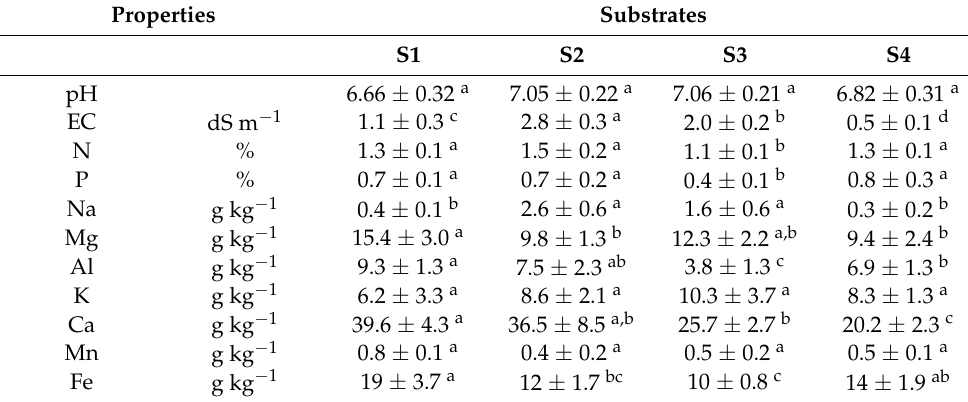
Table 1. Chemical properties of the four substrates.